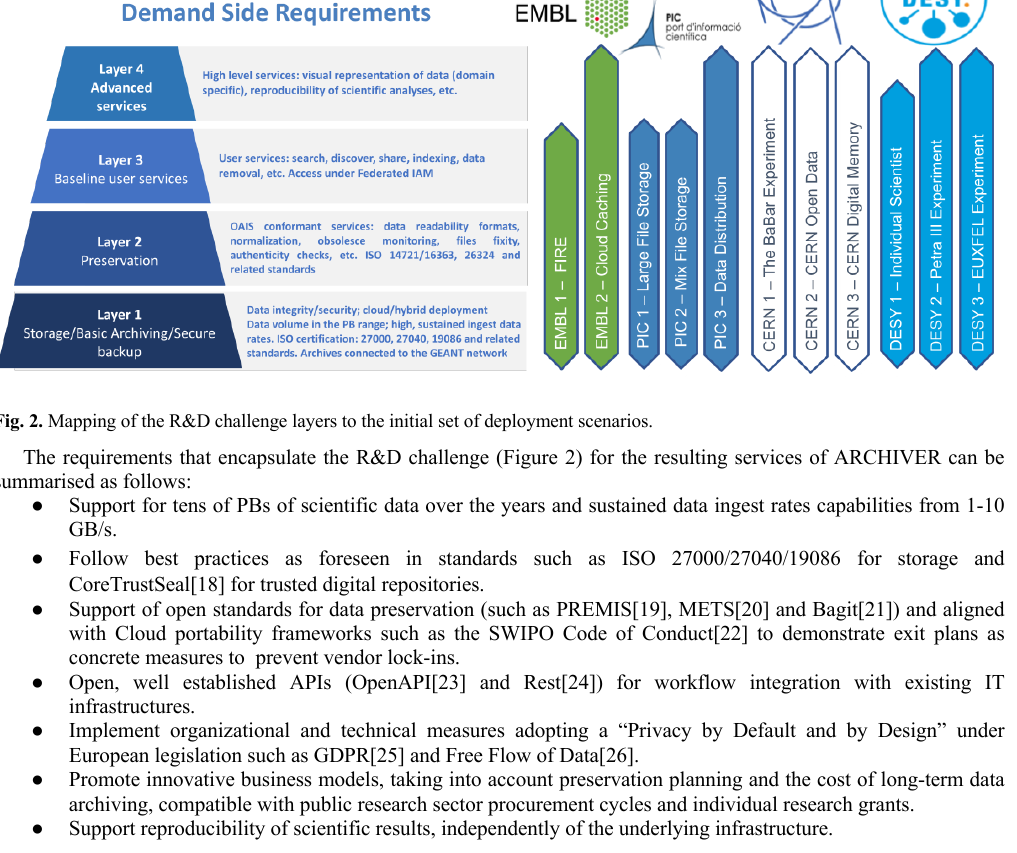
Fig. 1. R&D challenge high level architecture resulting from the ARCHIVER preparation phase.